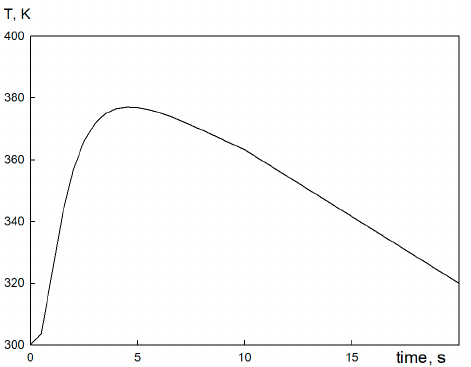
Figure 13. Temperature change at the control point caused by one thin twig hitting the wood layer over time: L = 70 mm, H = 5 mm, D = 5 mm.